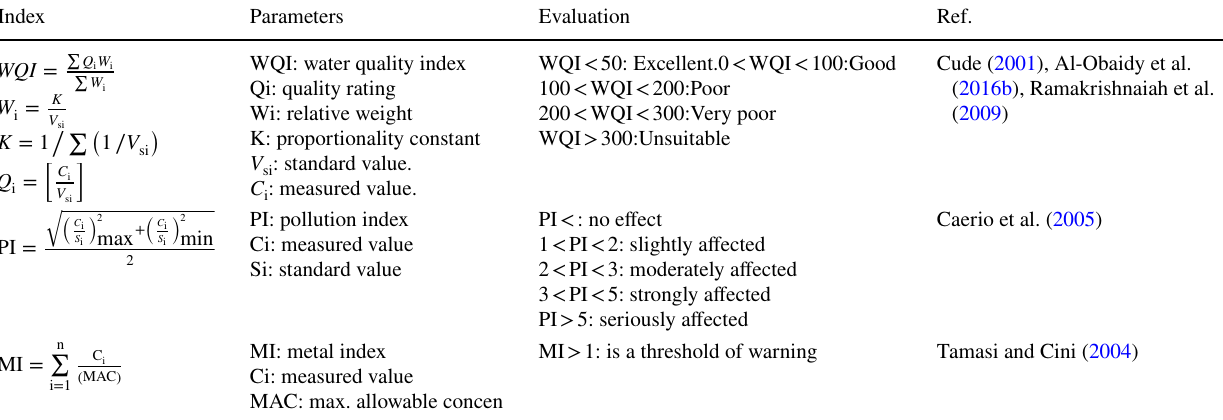
Table 2 The calculations and evaluations of the selected indices Index Parameters Evaluation